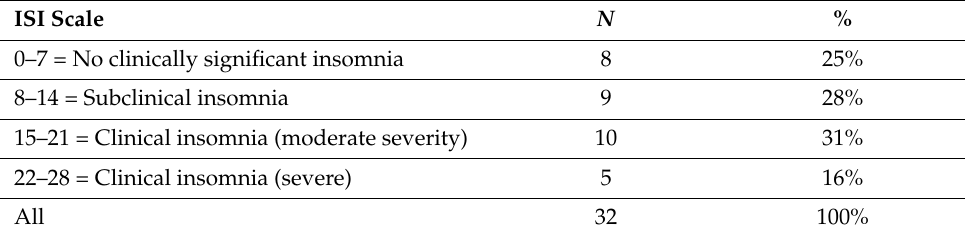
Table 6. Characteristics of sleep disorders after 6